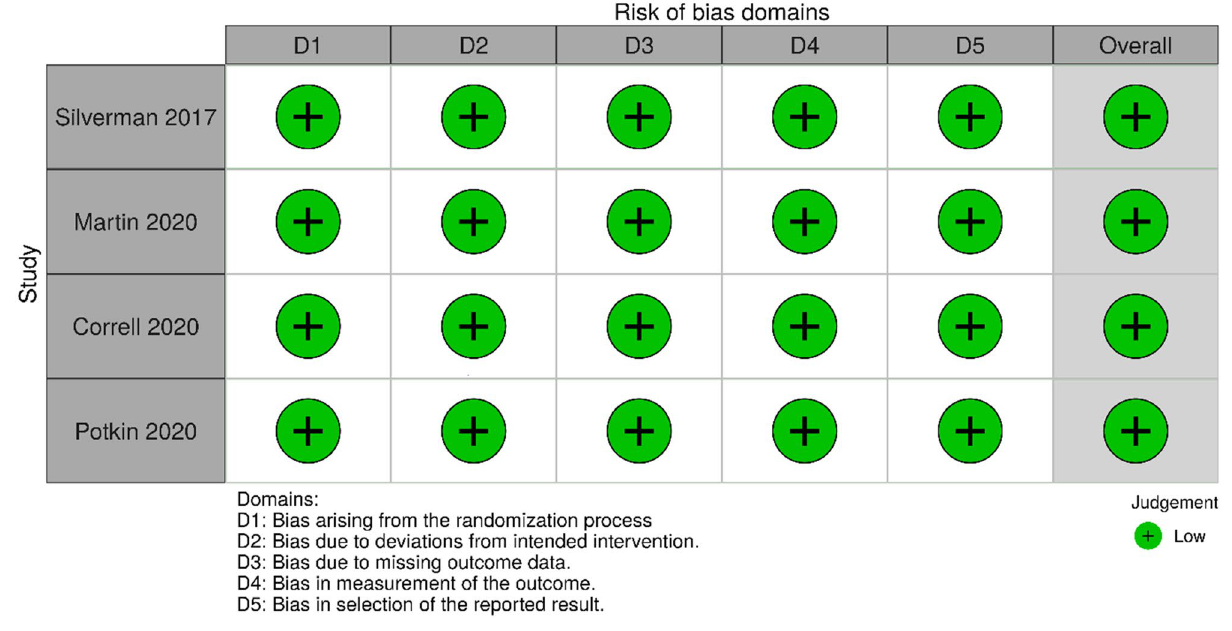
Figure 2. Risk of bias within four trials included in the meta-analysis of randomized controlled trials comparing olanzapine/samidorphan and olanzapine for mitigating olanzapine-induced weight gain and cardiometabolic disturbances.